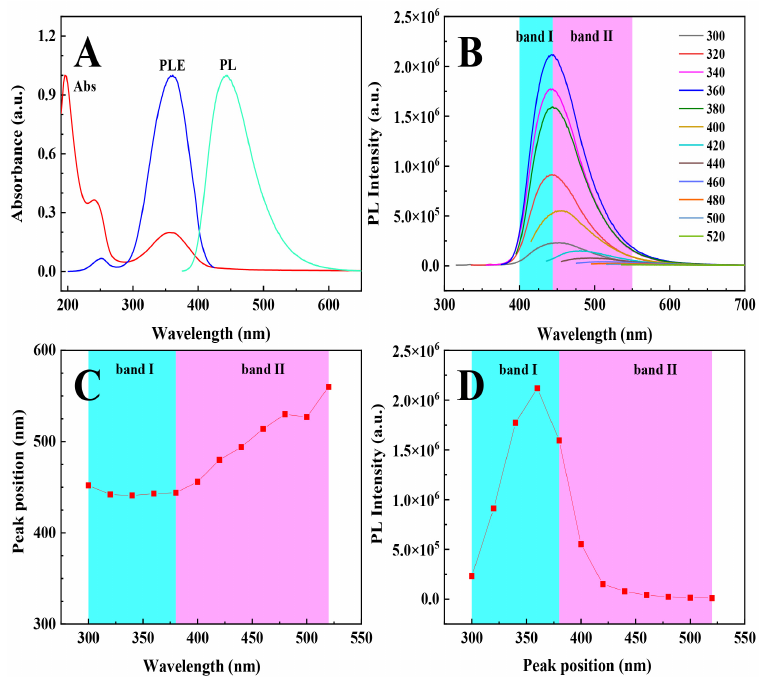
Figure 5. ( A ) The absorption (Abs), excitation (PLE), and emission (PL) spectra of PEI@CNDs; ( B ) the PL spectra of PEI@CNDs under various excitation wavelengths; ( C ) the peak positions, and ( D ) the maximum intensities of the PL spectra varying with the excitation wavelengths in ( B ). The concentration of the PEI@CNDs is 0.1 mg/mL.